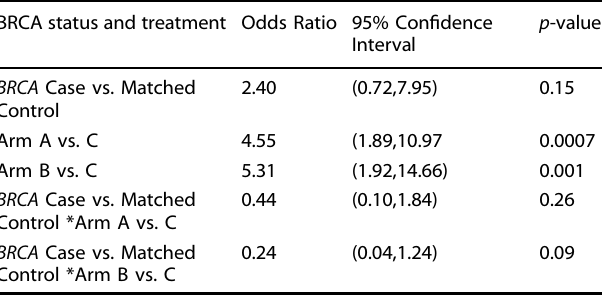
Table 3. Logistic regression for pathologic complete response by BRCA status and treatment.